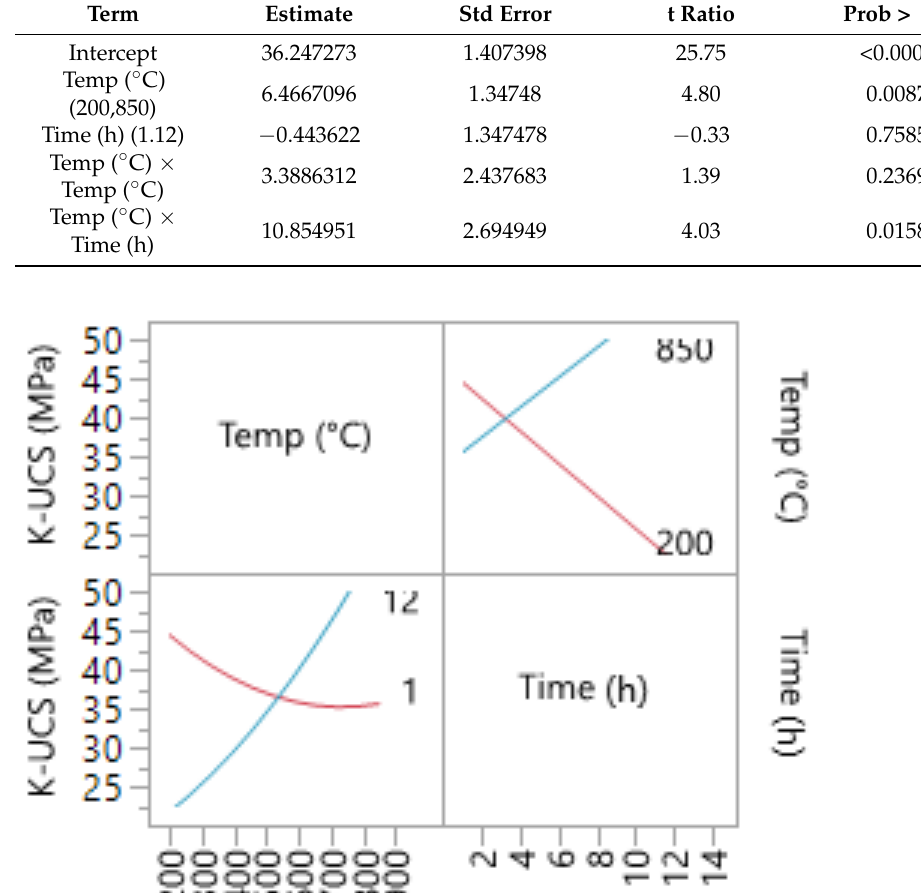
Figure 10. Prediction profiler for K1-based geopolymer cement.